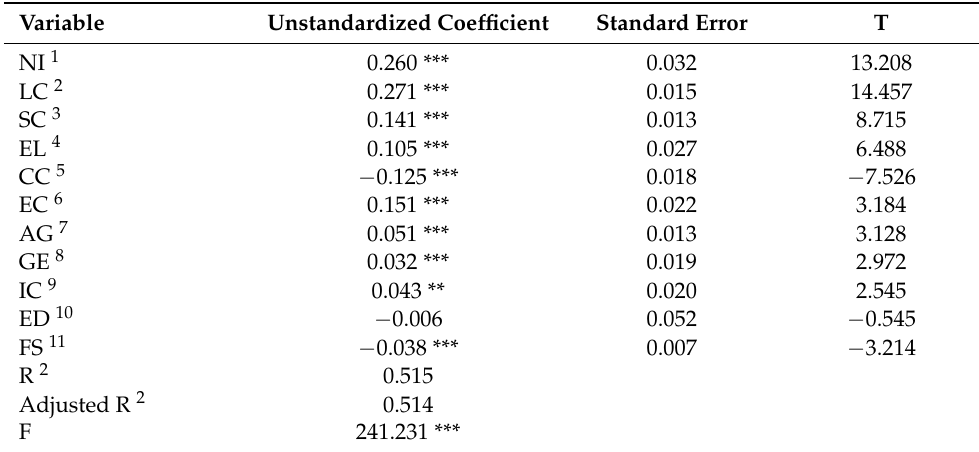
Table 2. Regression results of individual–group-level factors on the